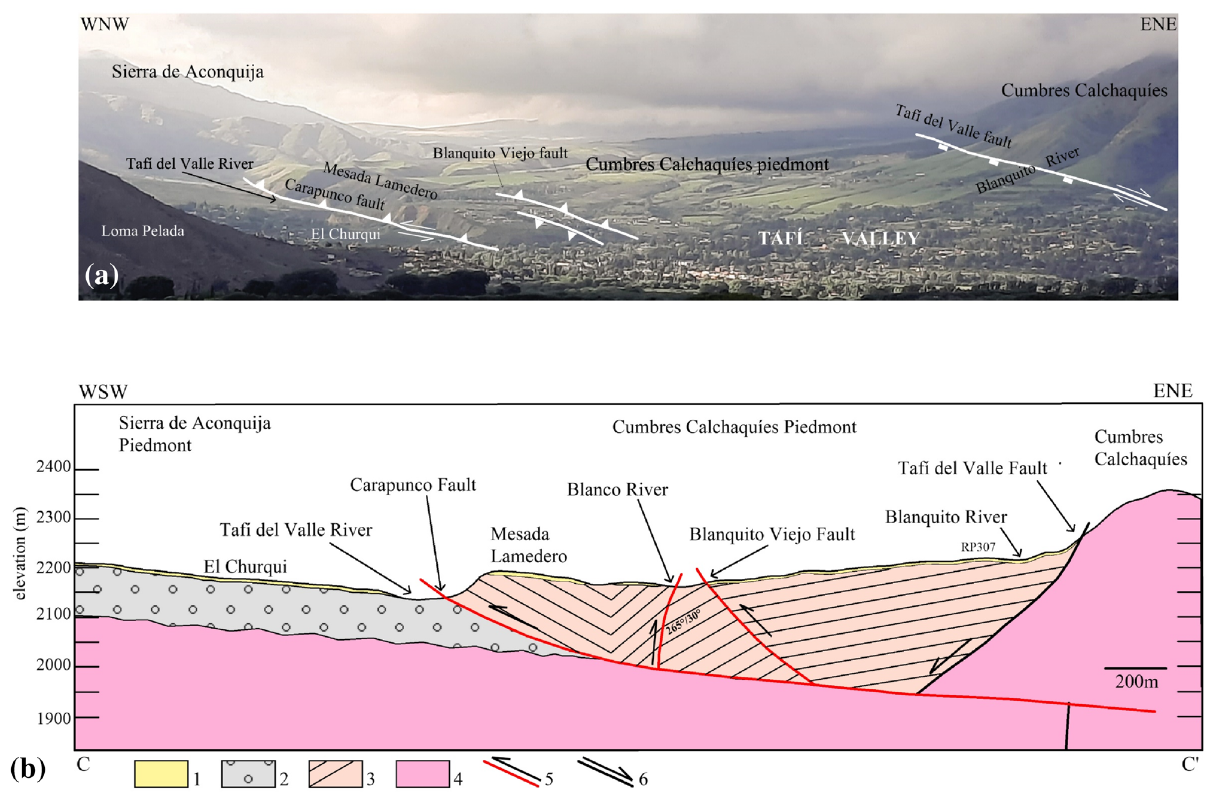
Lamedero positive relief structure, formed by the Carapunco and Blanquito Viejo faults. It is observed that the foothills of the Cum‑ bres Calchaquíes are raised and folded over the foothills of the Sierra de Aconquija. 1: Loess deposits (Q). 2: Alluvial fan deposits (Q). 3: Alluvial fan deposits (Q). 4: Proterozoic basement. 5: Recent reverse faults. 6: Normal